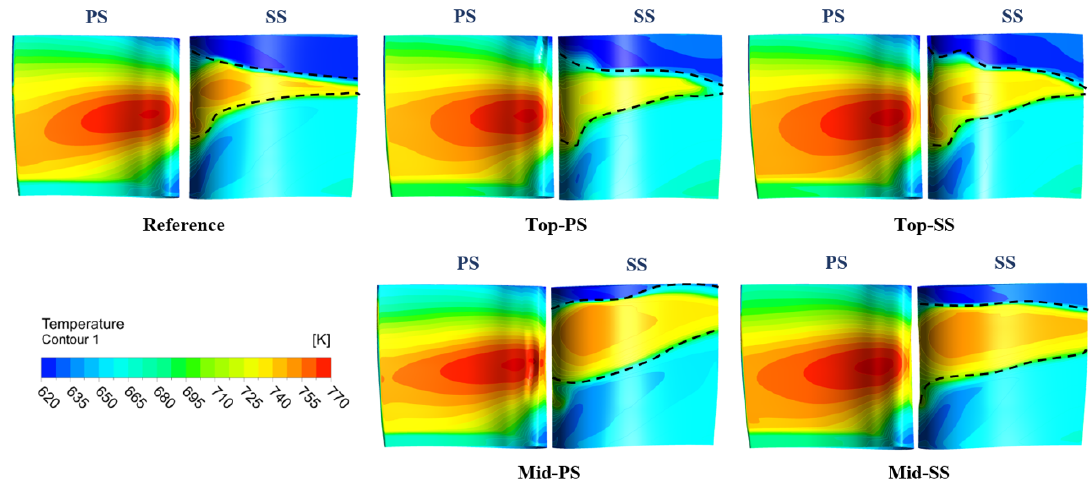
Figure 6. Temperature distribution on the R 1 blade under various blade conditions.